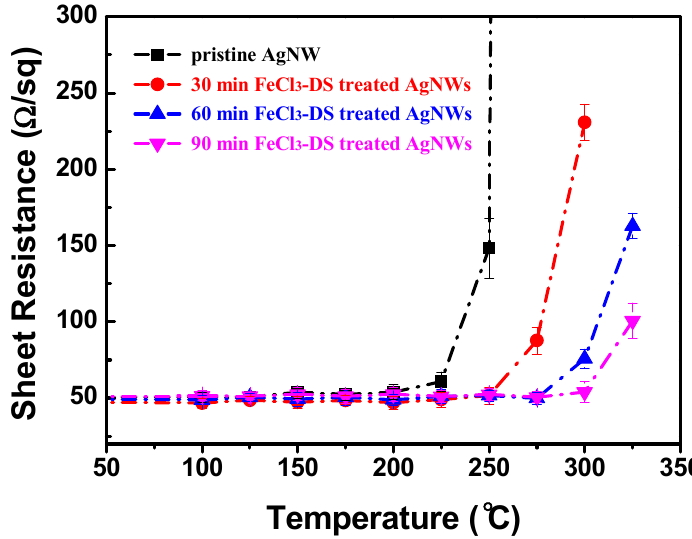
Figure 7. Sheet resistance variation of AgNW TCFs of 100 nm-thick AgNWs in the thermal test: pristine AgNWs (blank line) and AgNWs treated with 0.042 mM FeCl 3 -DS for 120 min (red line).